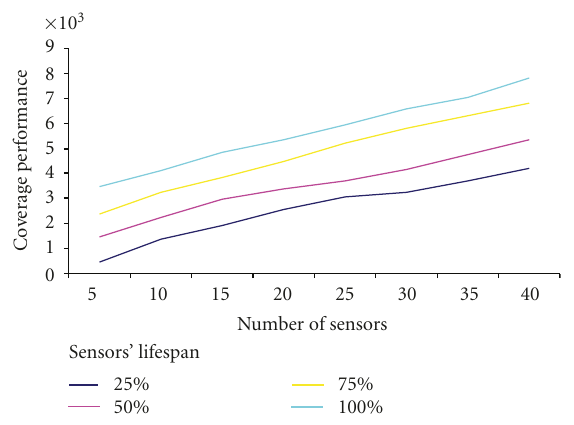
Figure 19: Tradeo ff between sensors’ lifespan and number of sen- sors using GA.